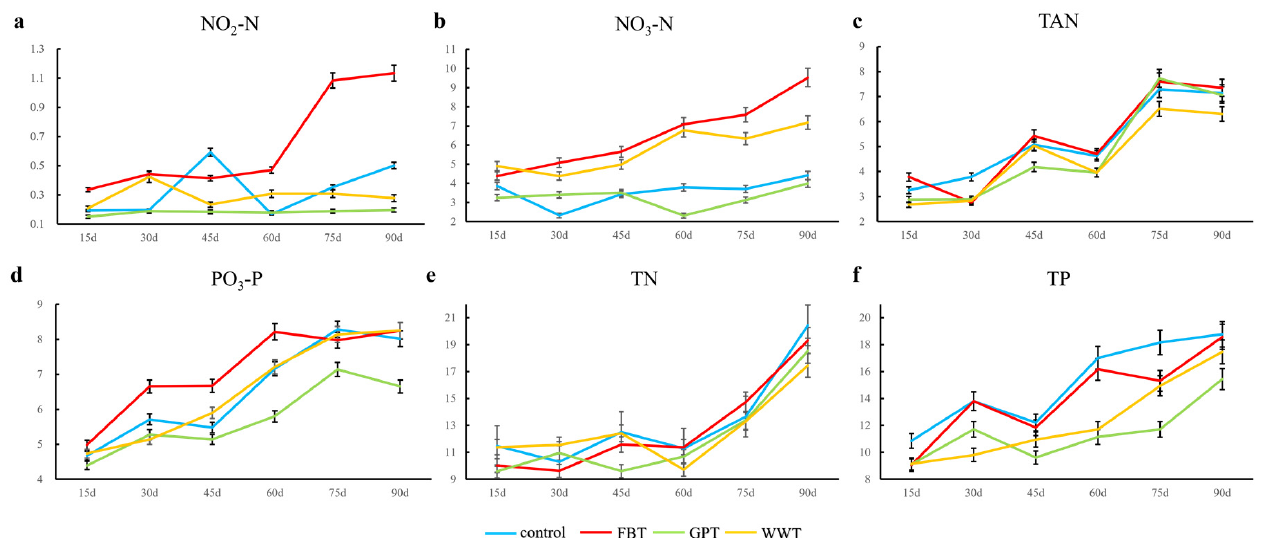
Figure 1. The time-dependent changes of six water quality parameters in the four culture modes. ( a ) NO 2 -N, nitrite nitrogen; ( b ) NO 3 -N, nitrate nitrogen; ( c ) TAN, total ammonia nitrogen; ( d ) PO 4 -P, soluble reactive phosphorus; ( e ) TN, total nitrogen; ( f ) TP, total phosphorus. FBT, faba bean treatment; GPT, grass powder treatment; WWT, waving water treatment with commercial feed.